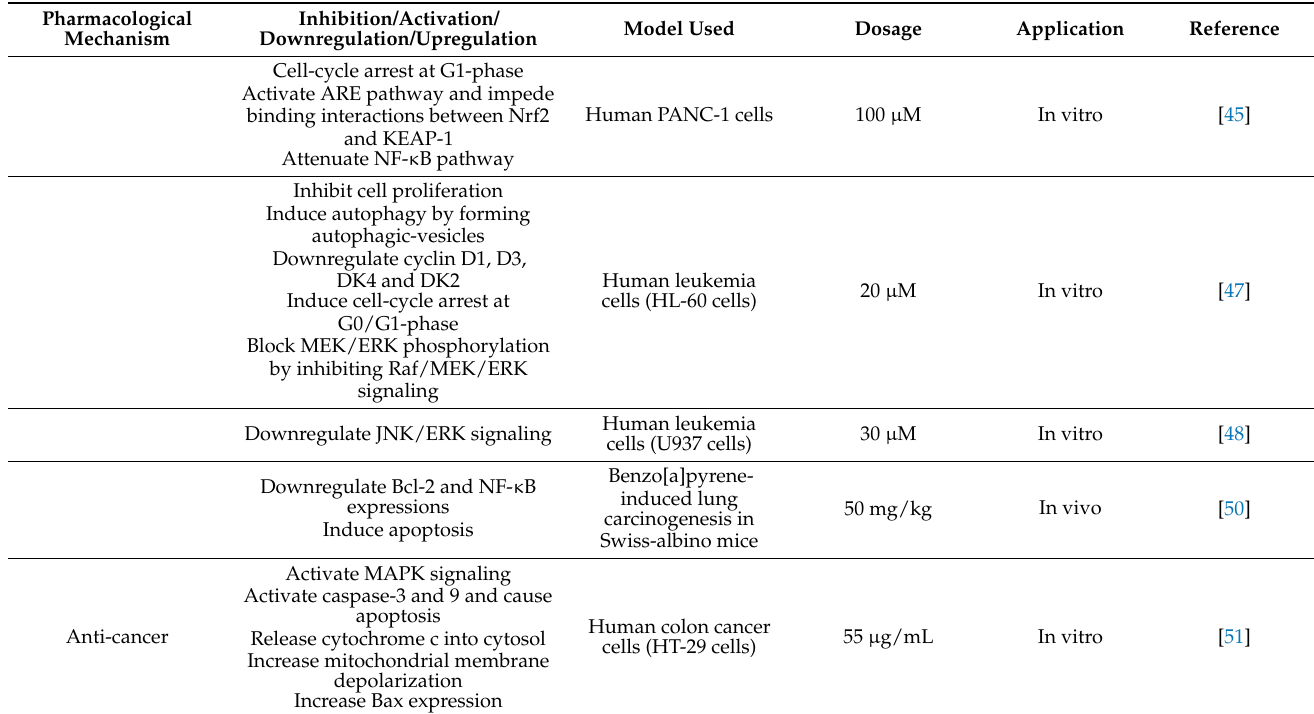
Table 1. Mechanism and function of esculetin in treatment of